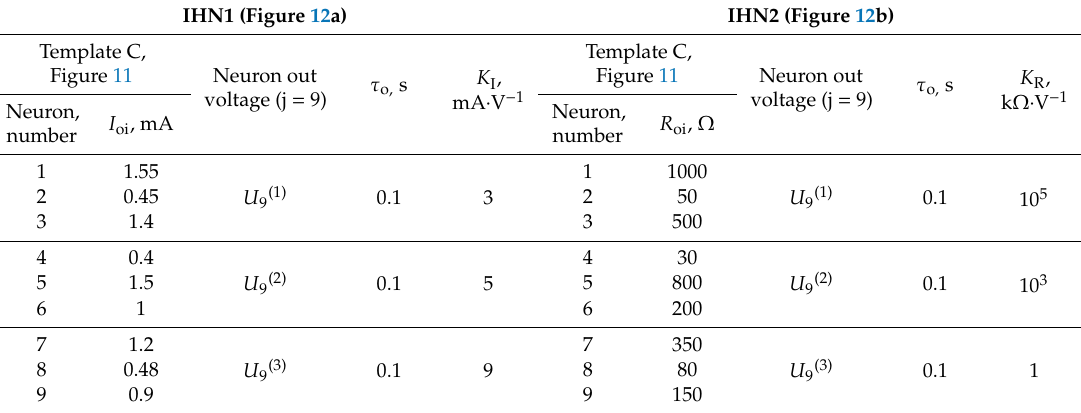
Table 4. Calculation parameters of IHN1 (Figure 12a) and IHN2 (Figure 12b) for the template C (Figure